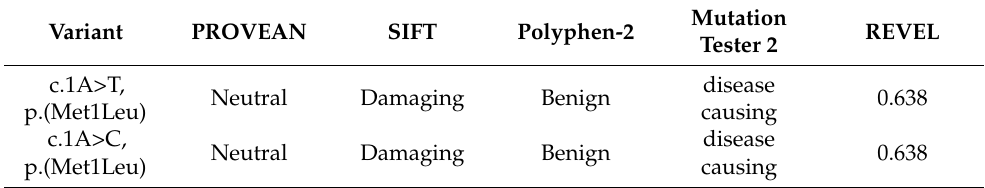
Table 1. In silico results obtained by the different bioinformatics tools.